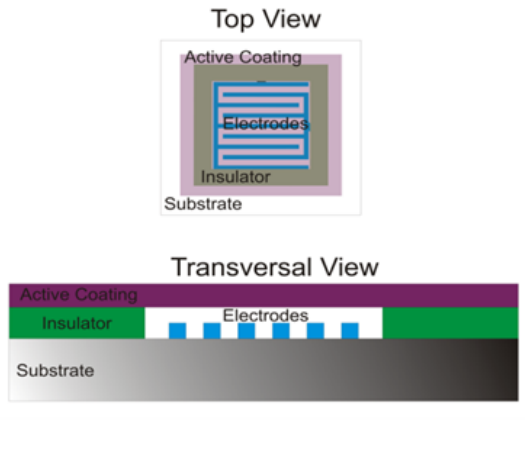
Figure 1. Scheme (top and transversal view) of one single sensor.